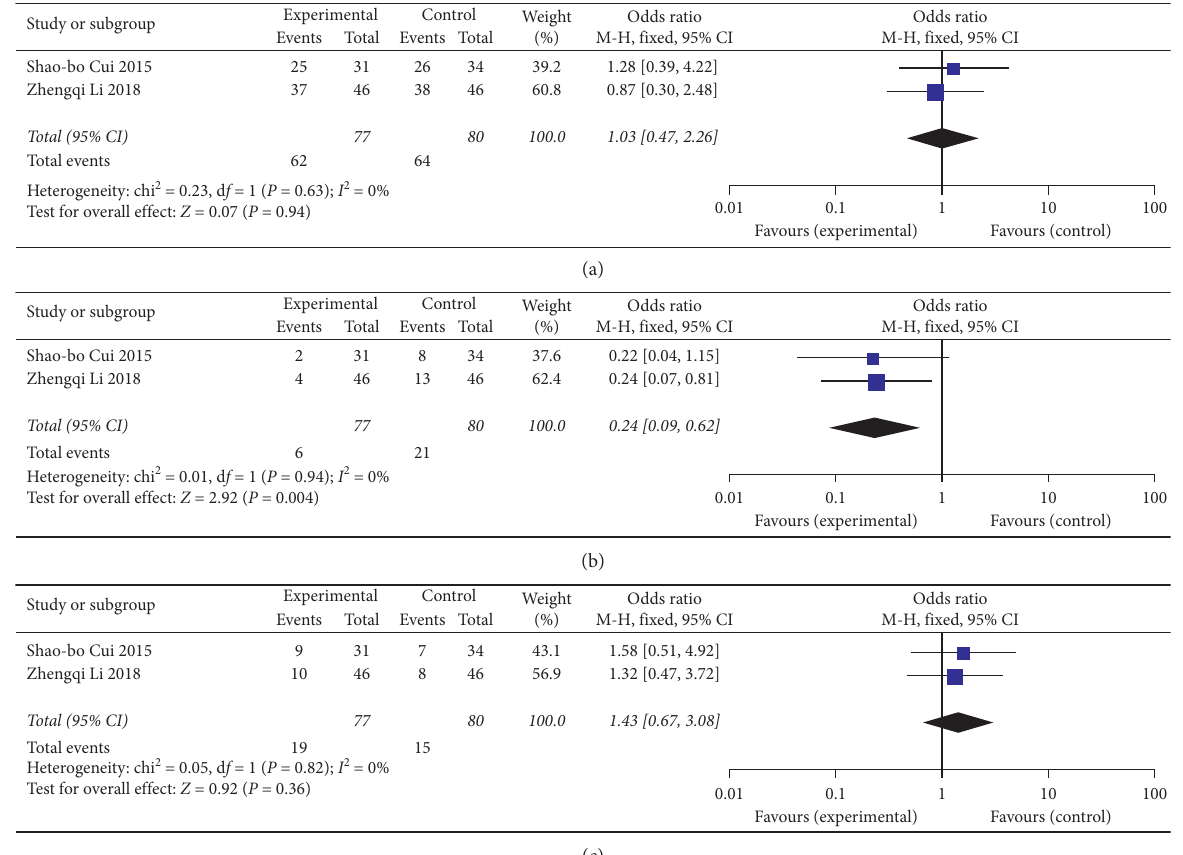
Figure 4: Effect and safety of anticoagulant with different doses of enoxaparin (1.0mg/kg q 12h in the experimental group and 1.5 mg/kg qd in the control group): (a) analysis of recanalization rate; (b) bleeding events; (c) other adverse